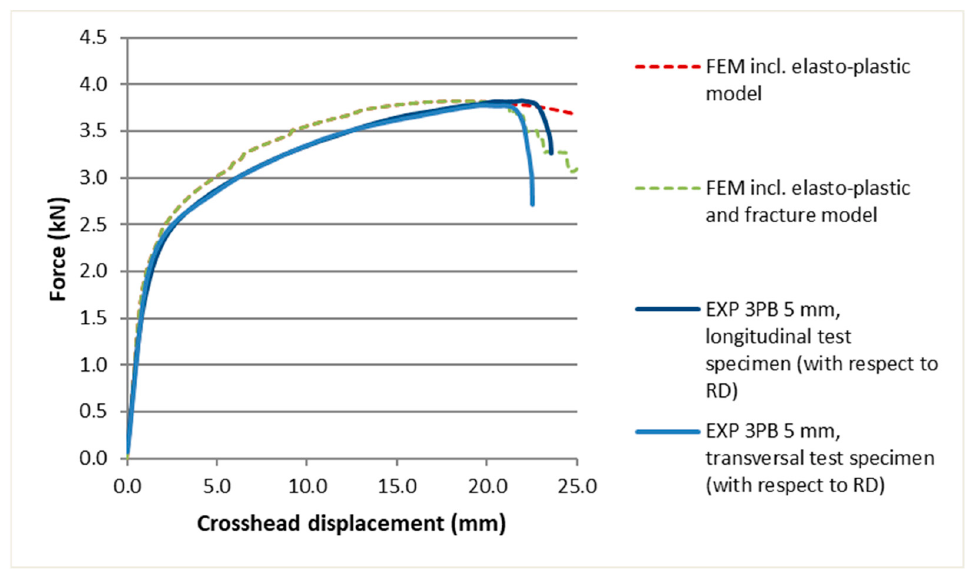
Figure 5. Good correlation between the force from the measurement and the simulation of the 3PB.